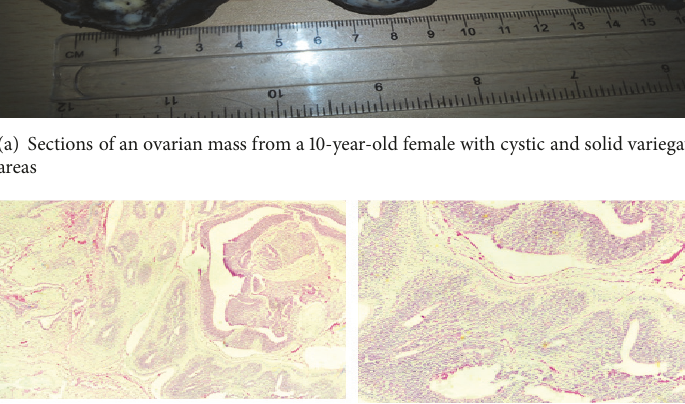
Figure 2: Case two: A 10-year-old girl with right ovarian mass.